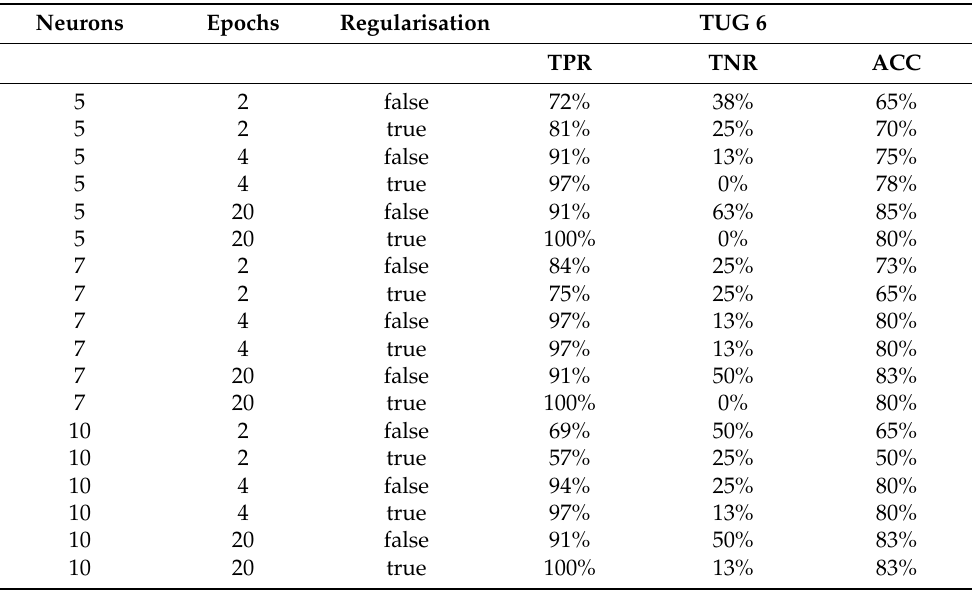
Table 3. Sensitivity (true-positive rate, TPR), specificity (true-negative rate, TNR), and accuracy (ACC) for the faller classification using the TUG 6.